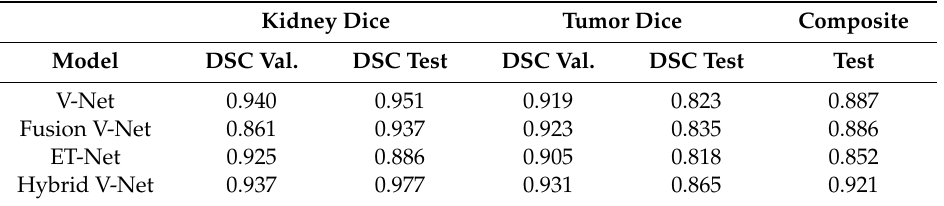
Table 2. Testing and validation Dice similarity coe ffi cient (DSC) of the four